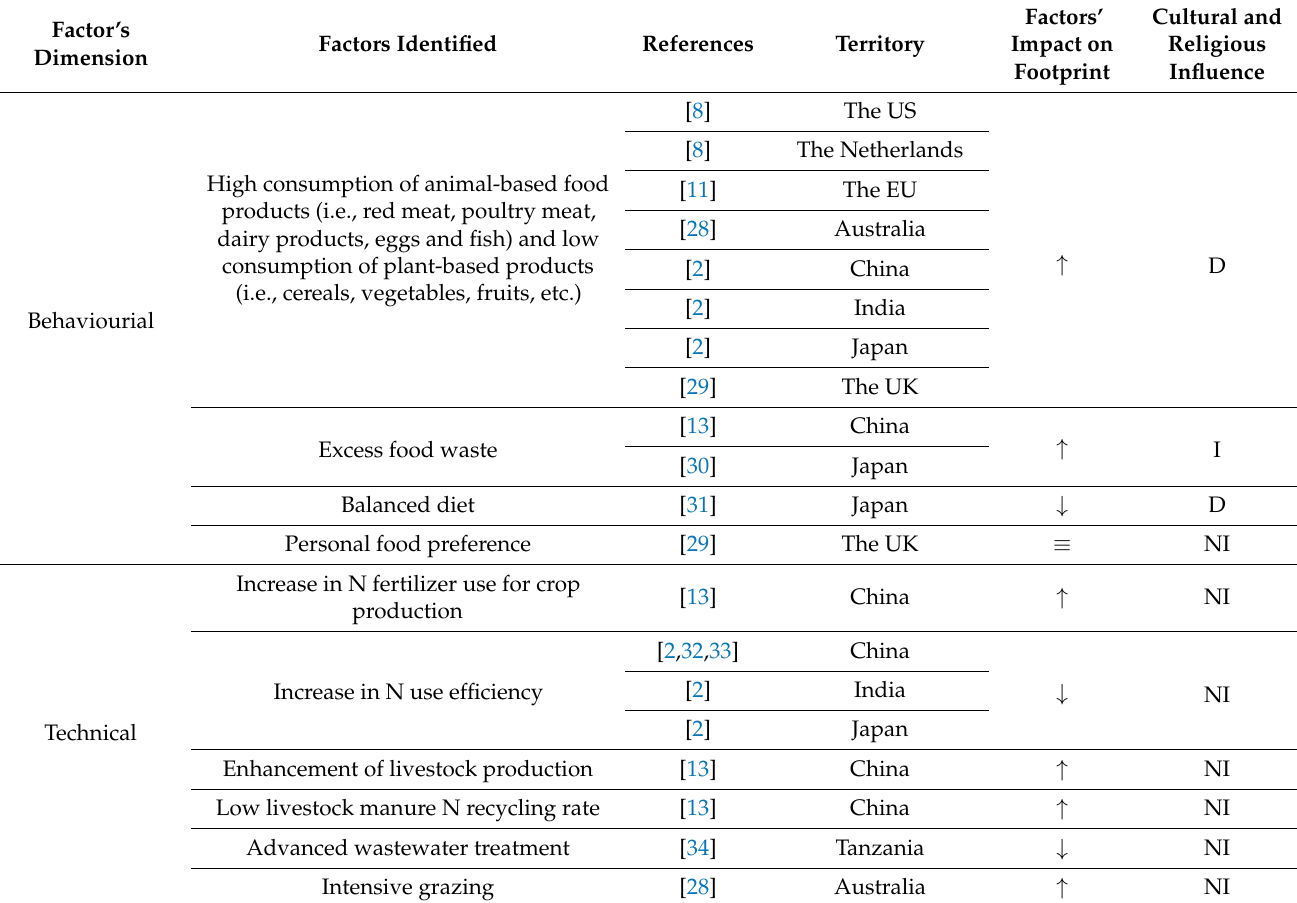
Table 3. Factors affecting food nitrogen footprint with possible cultural and religious